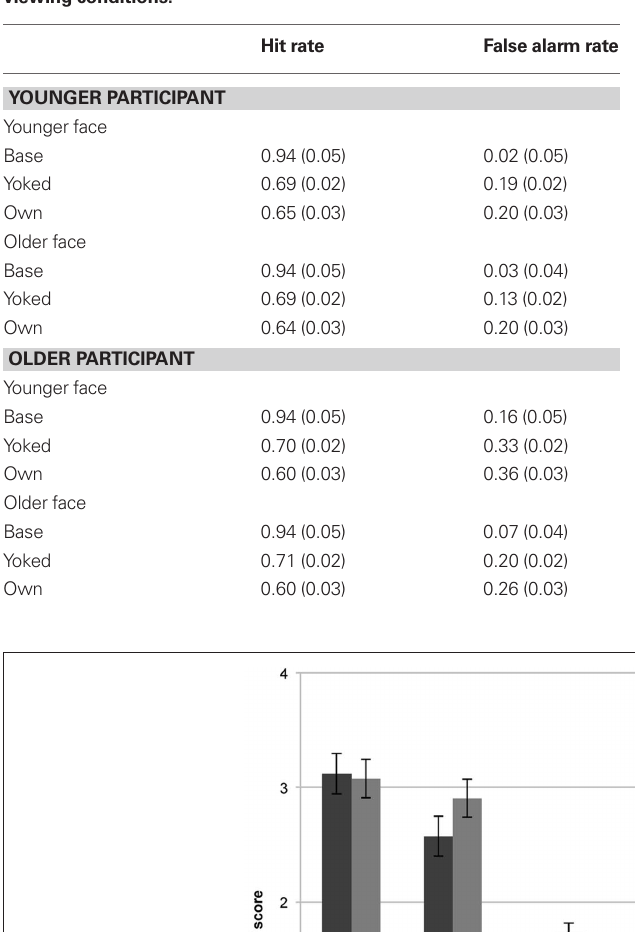
Table 4 | Mean (SE) hit and false alarm recognition rates for younger and older participants viewing younger and older faces across the different viewing conditions.